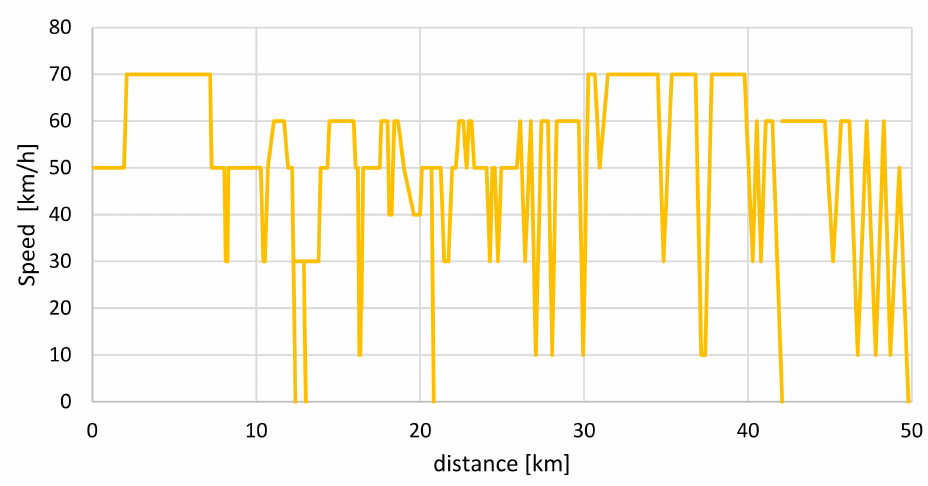
Figure 3. Reference Speed profile outward